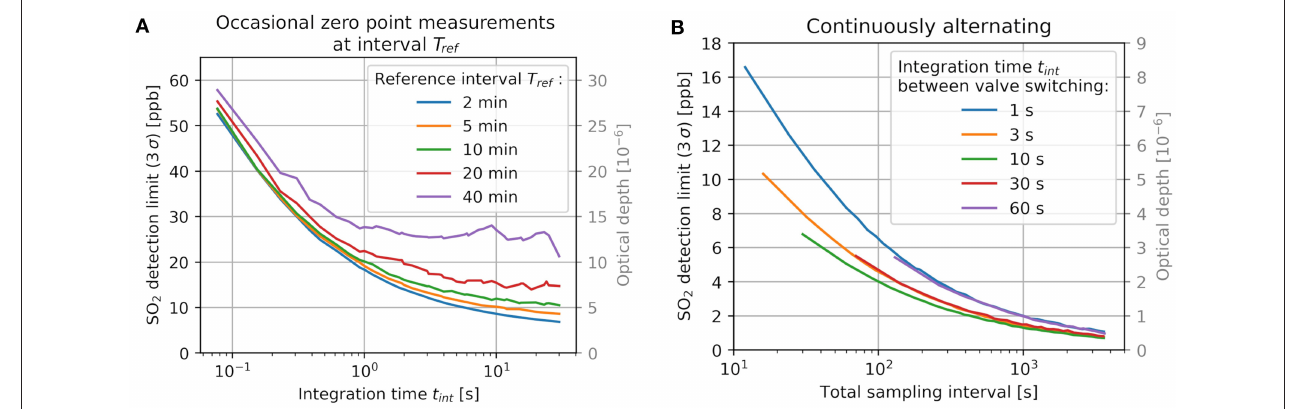
FIGURE 5 | Instrument detection limit (3 RMS of instrument noise) for different measurement protocols. (A) As a function of the detector integration time t int for × t int behavior is observed. (B) In case of continuous alternation between measurement and zero point different reference intervals T ref . For sufficiently short T ref a 1 / p measurement. Here an optimum is seen for 10 seconds integration time between switching.